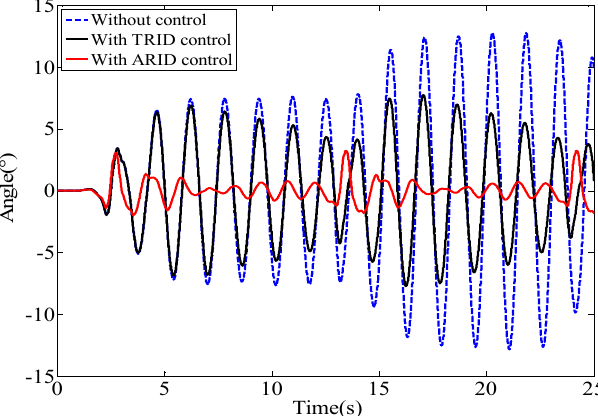
Figure 10. Numerical results of the swing angle of the structure with the TRID or ARID system.